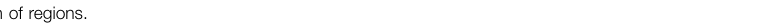
TABLE 2 | Description of regions. Panel